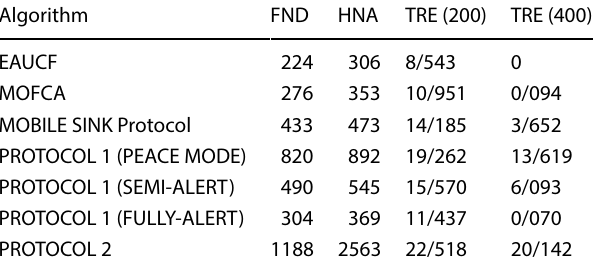
Table 3 Simulation results in scenario 2